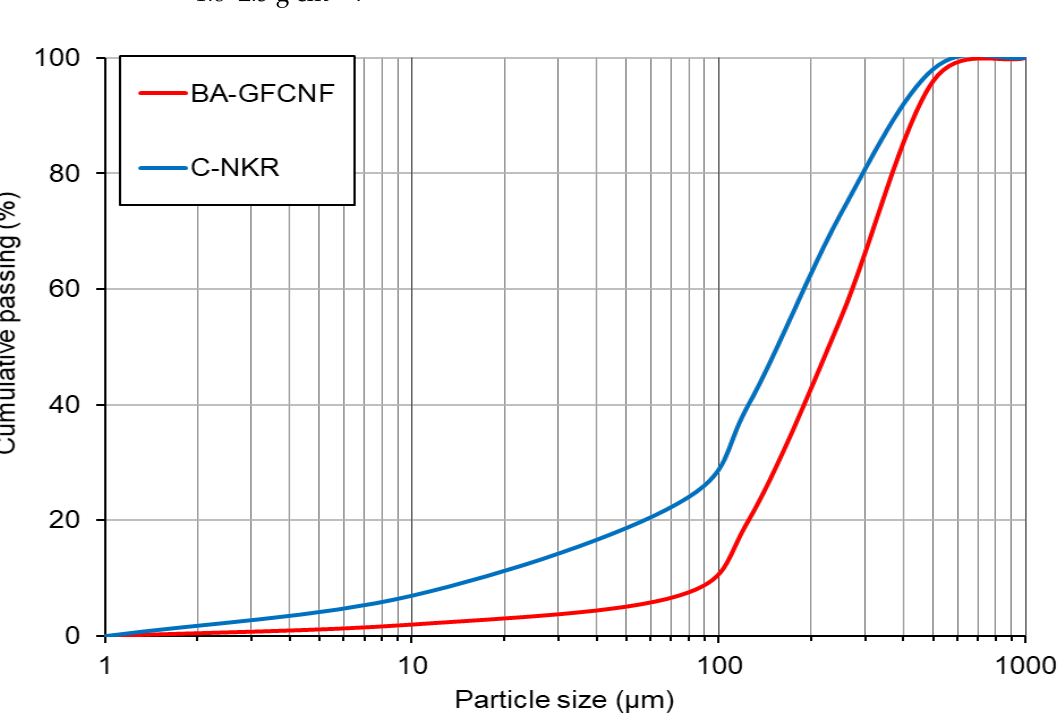
Figure 1. Particle size distributions of the BA GFCNF and C NKR .